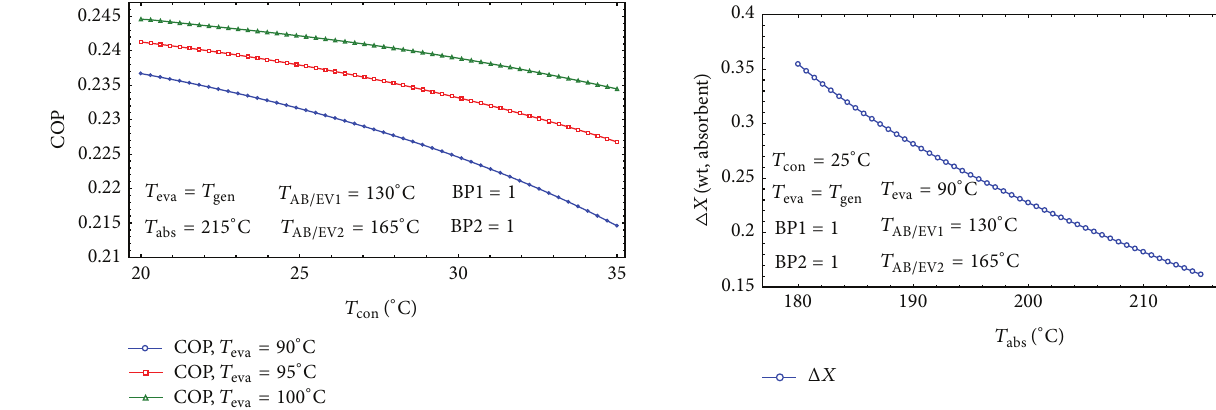
Figure 10: The effect of 𝑇 . different 𝑇 eva